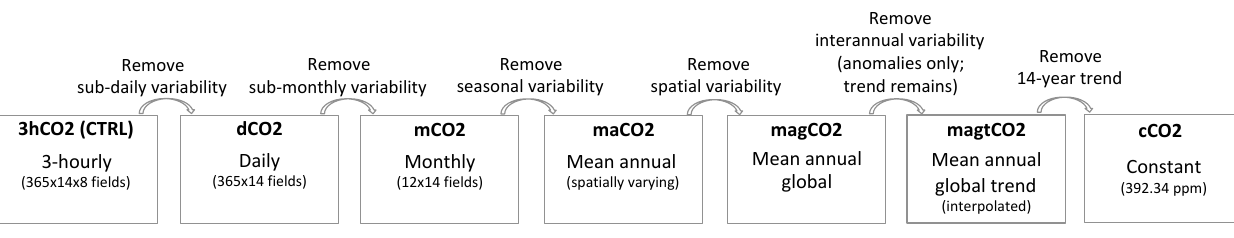
Figure 1. Schematic of the six simulations examined in this study, which were designed to isolate the impacts of the different facets’ spatiotemporal CO 2 variability on simulated carbon fluxes. The CO 2 concentrations were reconstructed from the NOAA CarbonTracker 3-hourly global CO 2